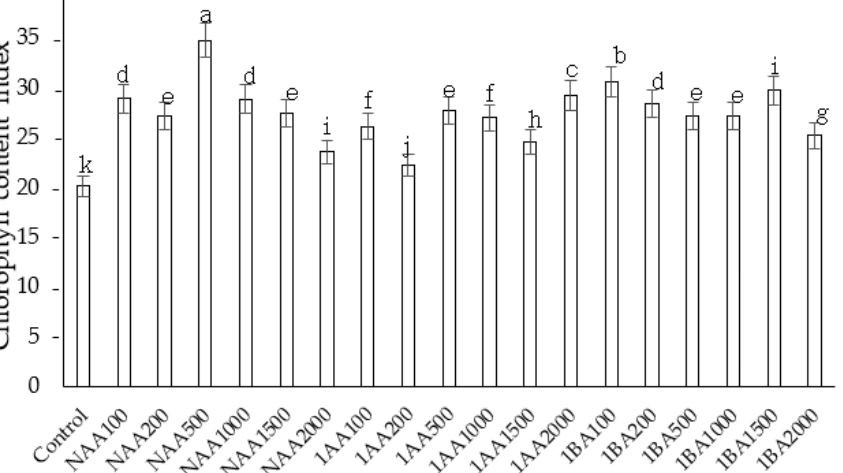
Figure 6. The effect of auxins on total chlorophyll content index in C. indicum. Values are reported as mean ± standard deviation of three parallel experiments. Different letters indicate statistical differences as assessed by Duncan’s multiple comparison tests ( p <